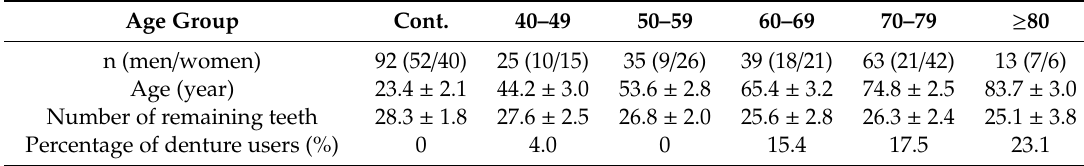
Table 1. Participants’